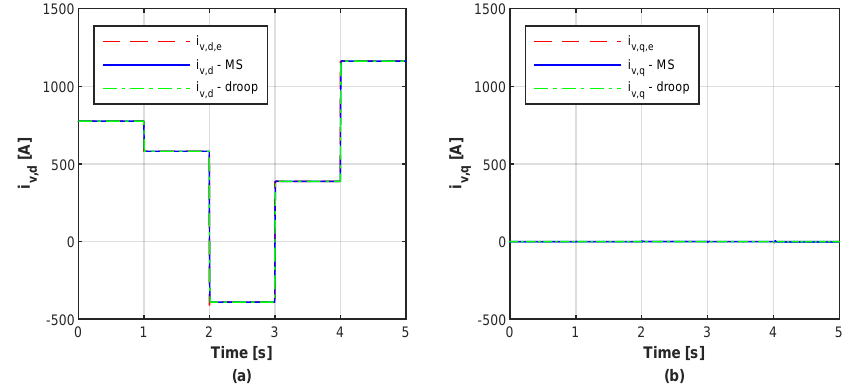
Figure 9. Output current response from terminal 2: ( a ) i v , d ; ( b ) i v , q .